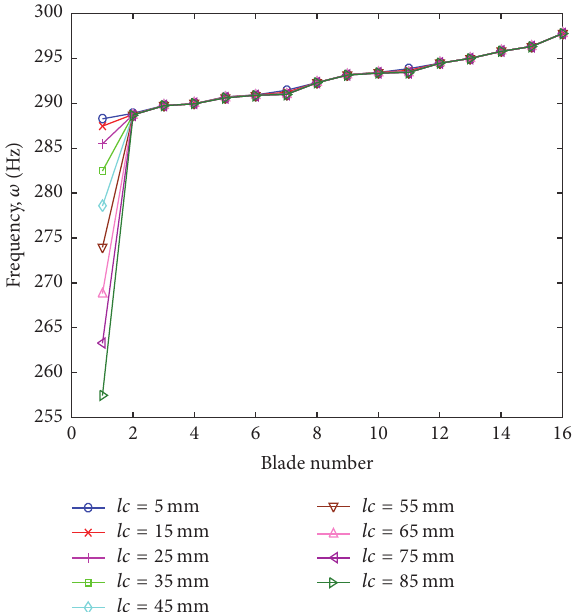
Figure 12: Natural frequencies of MRBs under different 𝑙𝑐